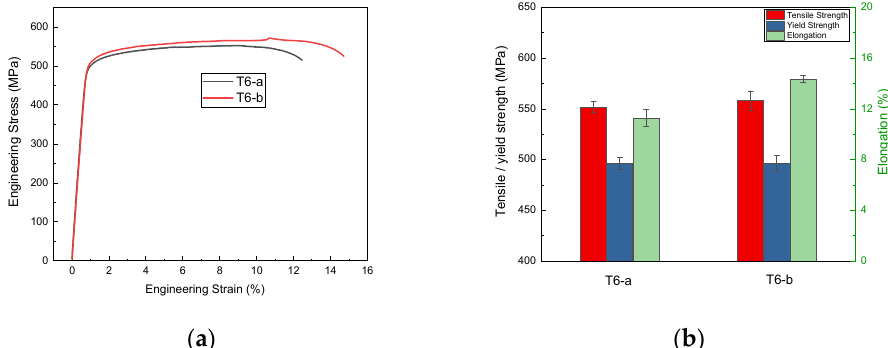
Figure 2. Stress–strain curves and tensile properties of Al-Mg-Zn-Cu alloy after T6 process with different parameters: ( a ) stress–strain curves; ( b ) tensile properties.